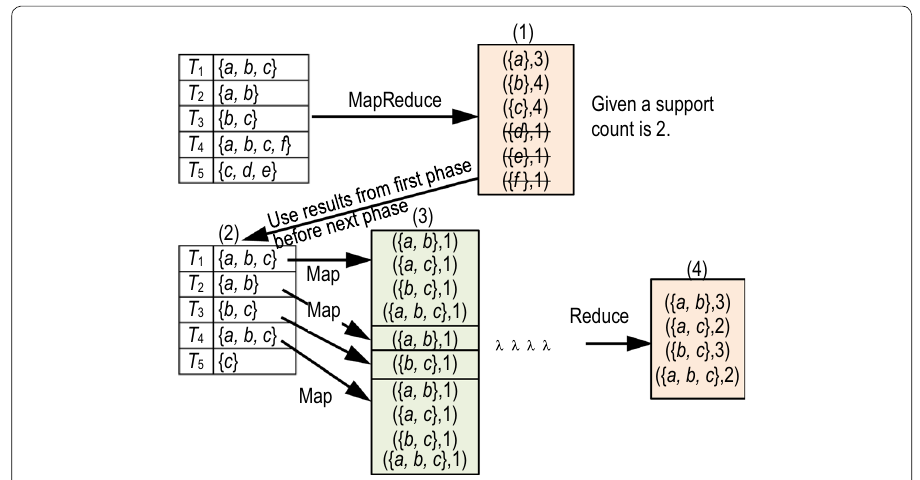
Fig. 6 Partial executions of AprioriPMR . Illustration of MapReduce execution of